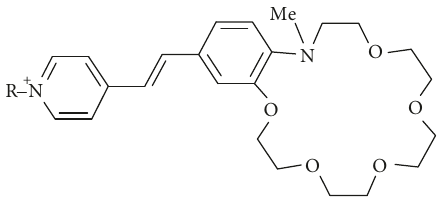
Figure 1: Chemical structure of the azacrown-containing dye OMS